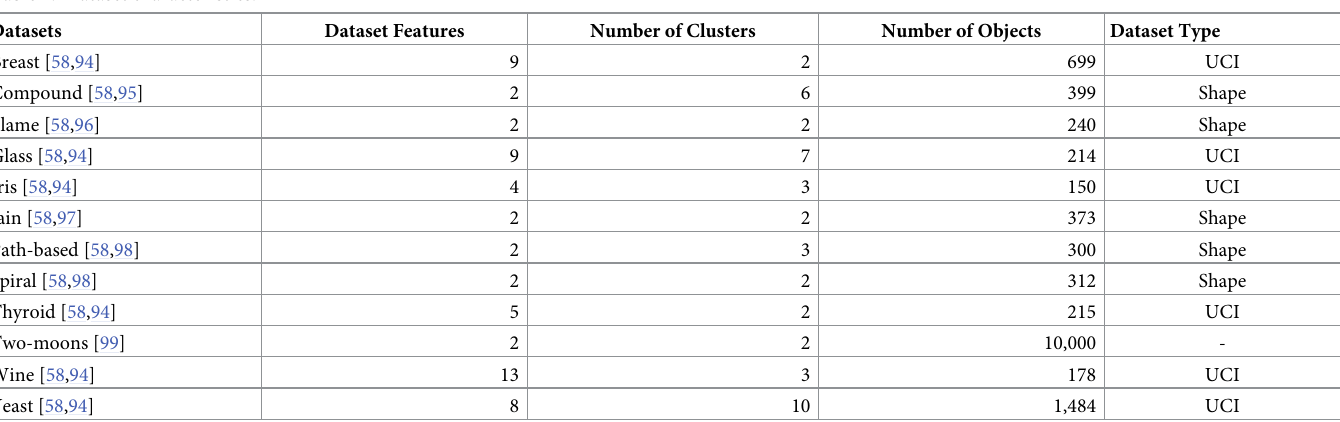
Table 4. Dataset characteristics.